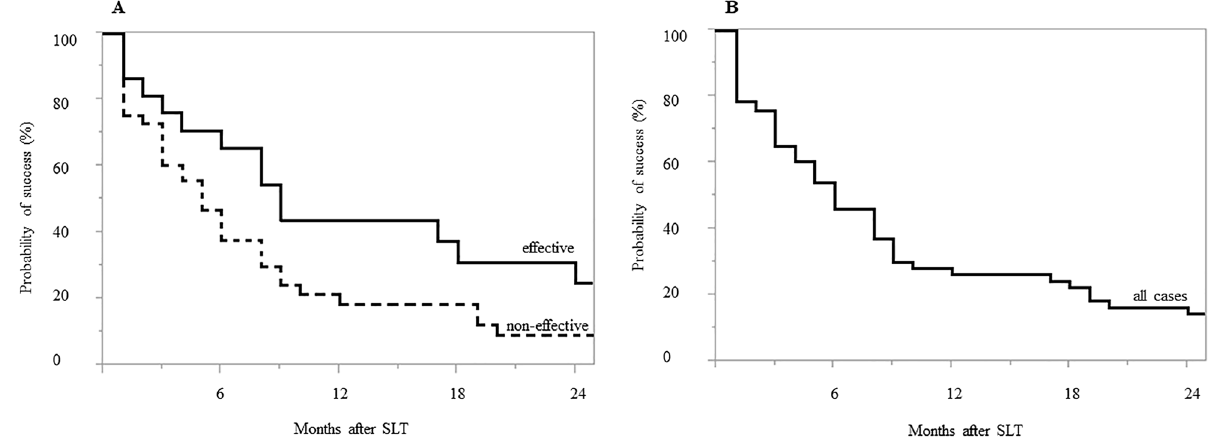
Figure 2. Kaplan–Meier survival curve of surgical outcomes in the ripasudil effective vs. non-effective eyes ( A ) and all cases ( B ). Significant differences were noted for the cumulative probability of success between the effective and non-effective groups ( P = 0.03).